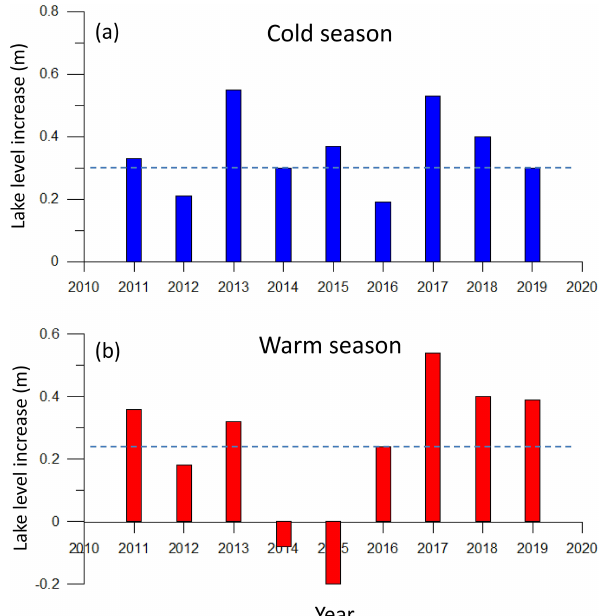
Figure 6. Seasonal lake level changes at Memar Co derived from CryoSat-2 satellite altimetry data between 2011 and 2019. (a) Cold season (November to June). (b) Warm season (June to